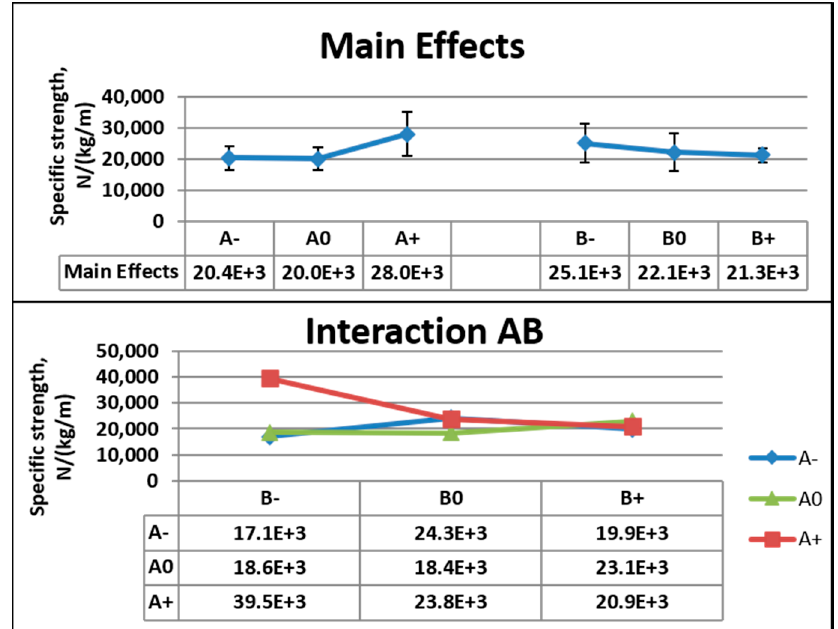
Figure 12. Main effects, standard deviation, and interactions for the tensile data of the original system.